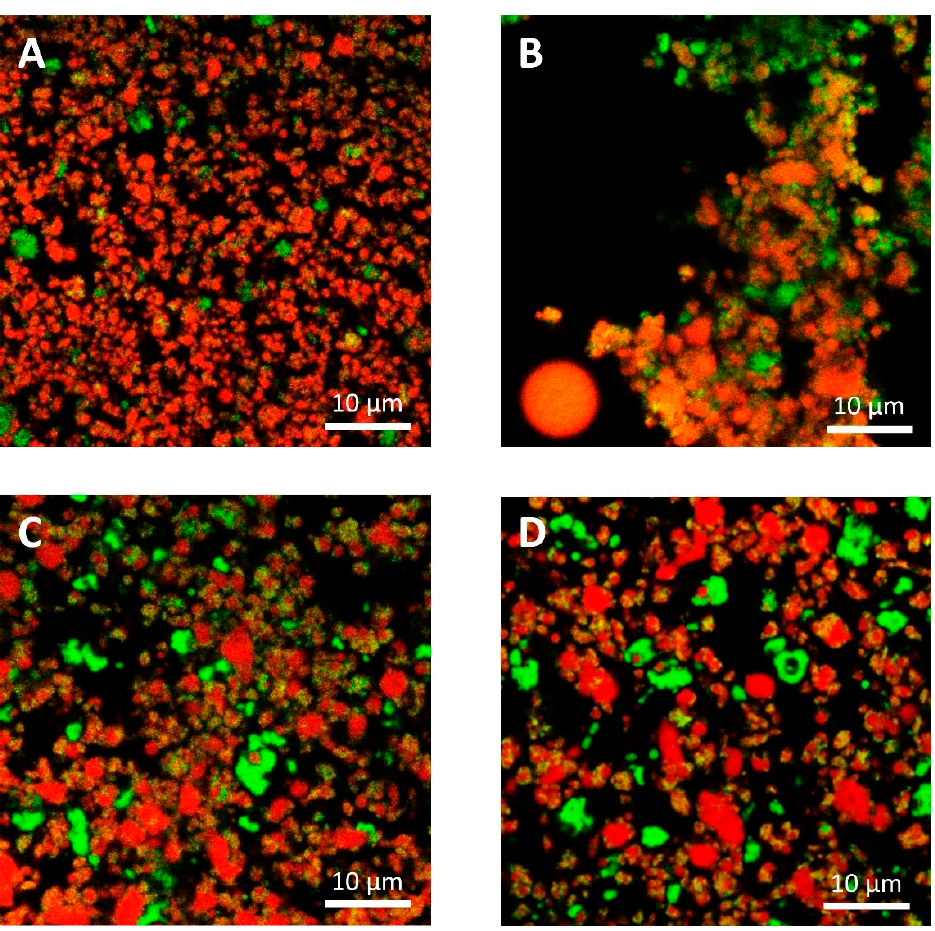
Figure 5. Confocal laser scanning micrographs of cream cheeses. Cream cheese A before freezing ( A ), after freezing ( B ). Cream cheese B before freezing ( C ), after freezing ( D ). Red: fat. Green: protein.